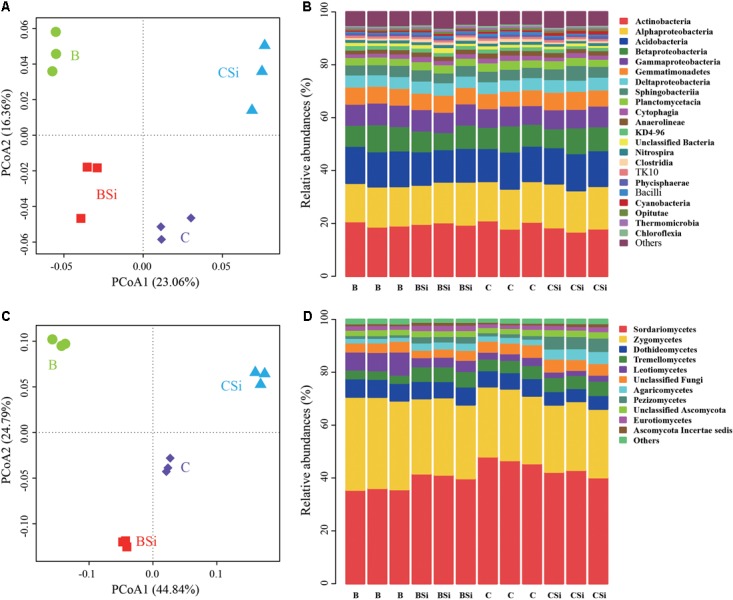
Principal coordinates analysis (PCoA) analysis of soil bacterial (A) and fungal (C) communities and relative abundances of main soil bacterial (B) and fungal (D) classes. OTUs were delineated at 97% similarity. The PCoA plots were based on the Bray–Curtis distances at the OTU level. For both bacterial and fungal communities, classes with average relative abundances >0.5% were shown. BSi and B represent bare soil treated with and without sodium silicate, respectively. CSi and C represent cucumber-cultivated soil treated with and without sodium silicate, respectively.